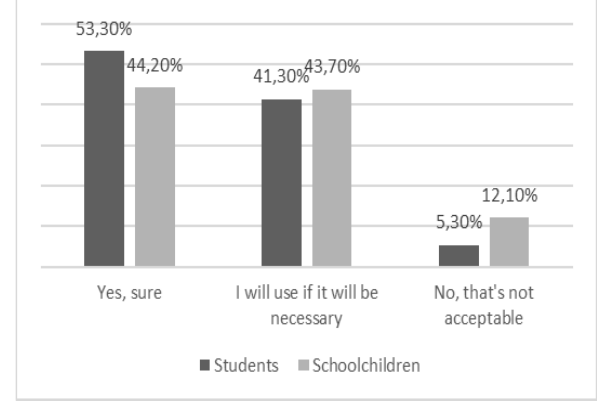
Figure 5. Respect for intellectual property